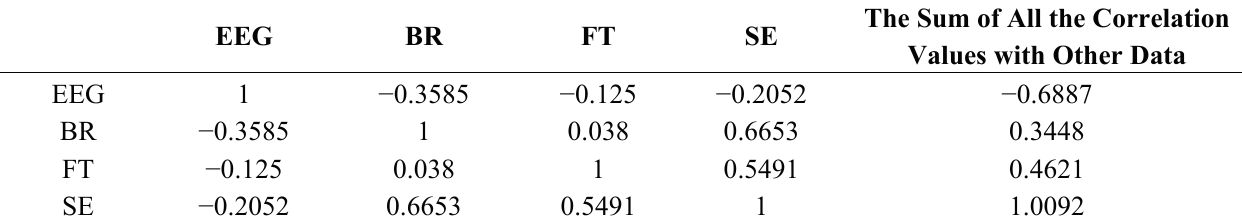
Table 9. Correlation matrix of four measured data of before and after (or in the last one minute) watching 3D